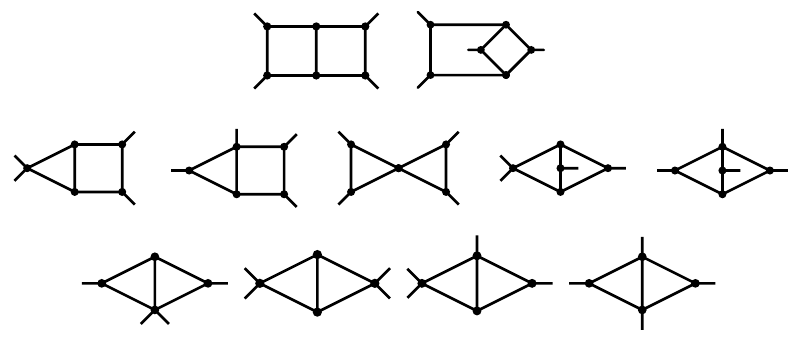
Figure 3: The integral topologies appearing in our ansatz for the two-loop four-point N = 8 SUGRA